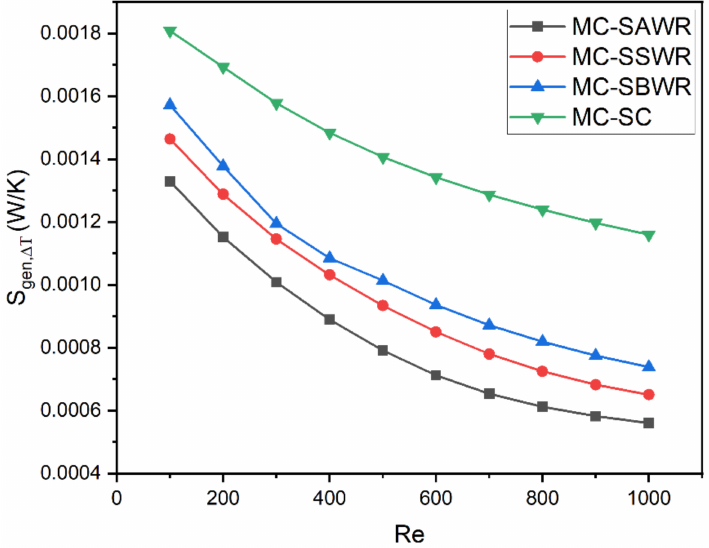
. S gen , ∆ T ) with Re for various